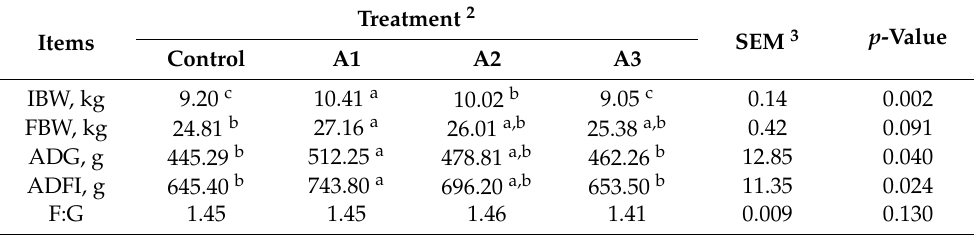
Table 1. Effects of acidifiers on the growth performances of weaned pigs 1 .